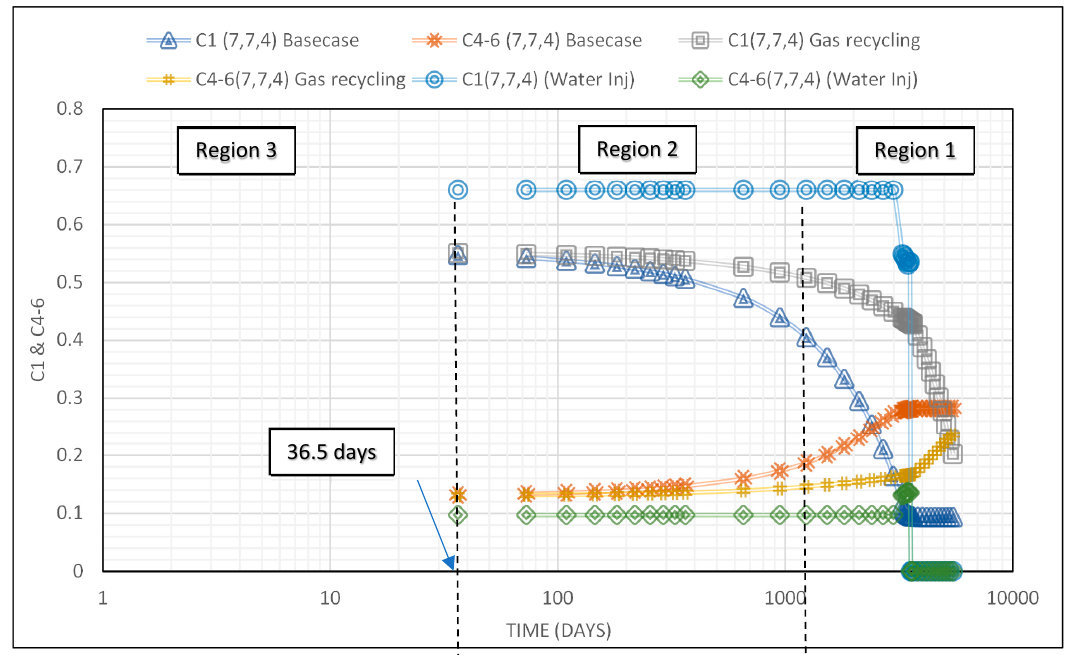
Figure 7. Fluid composition of C1 & C4-6 components over time for base, gas recycling, and water injection cases.